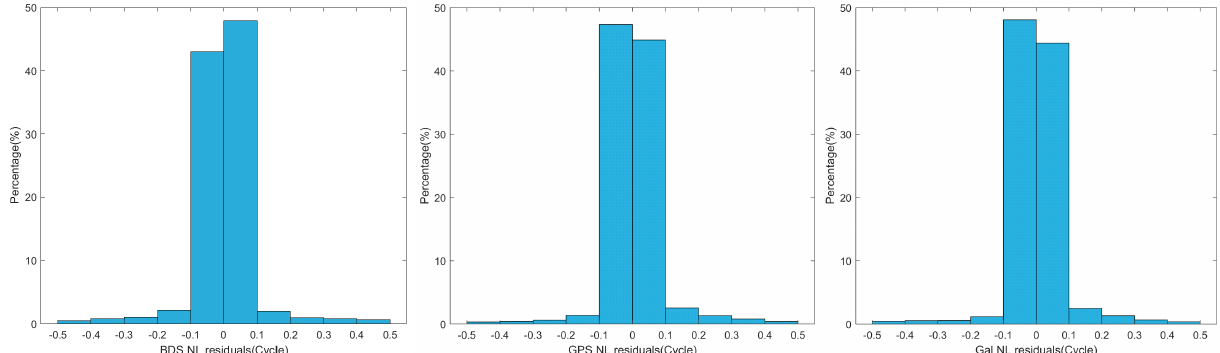
Figure 7. The NL residual distributions of the BDS-3, GPS, and Galileo on DOY 301,